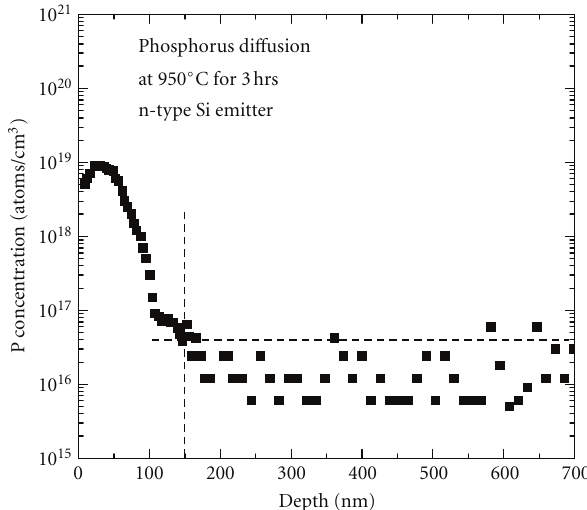
Figure 7: Profile of phosphorus concentration in RJSNW/p-type Si(100) solar cell, determined by secondary ion mass spectroscopy (SIMS). SNW/p-type Si(100) structures were formed by di ff usion of phosphorus at 950 ◦ C for 3 hrs.